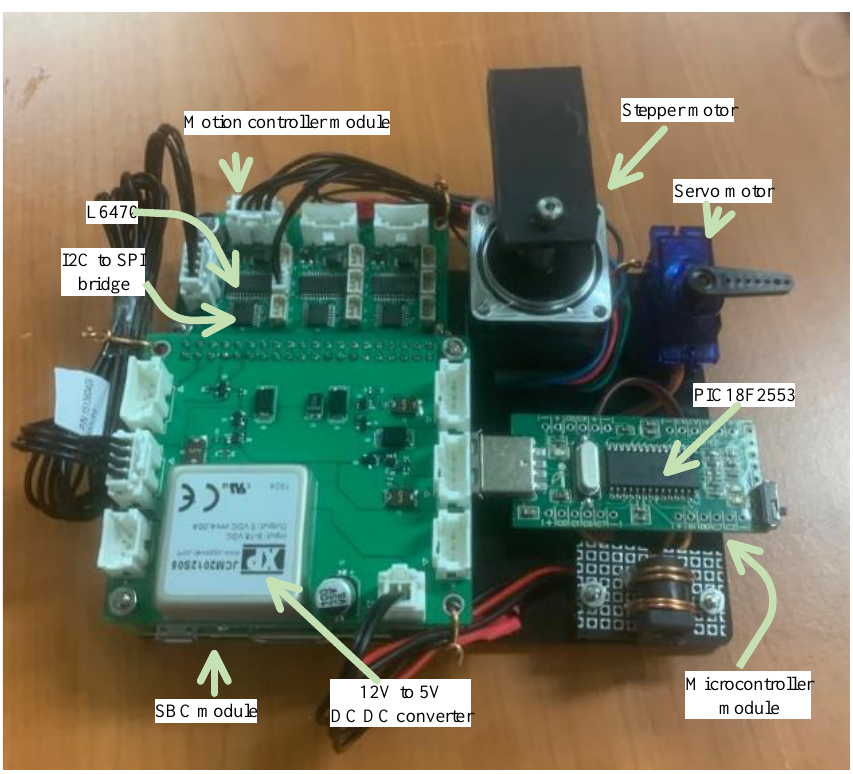
Figure 9. Emulator to evaluate the performance of the proposed software architecture .